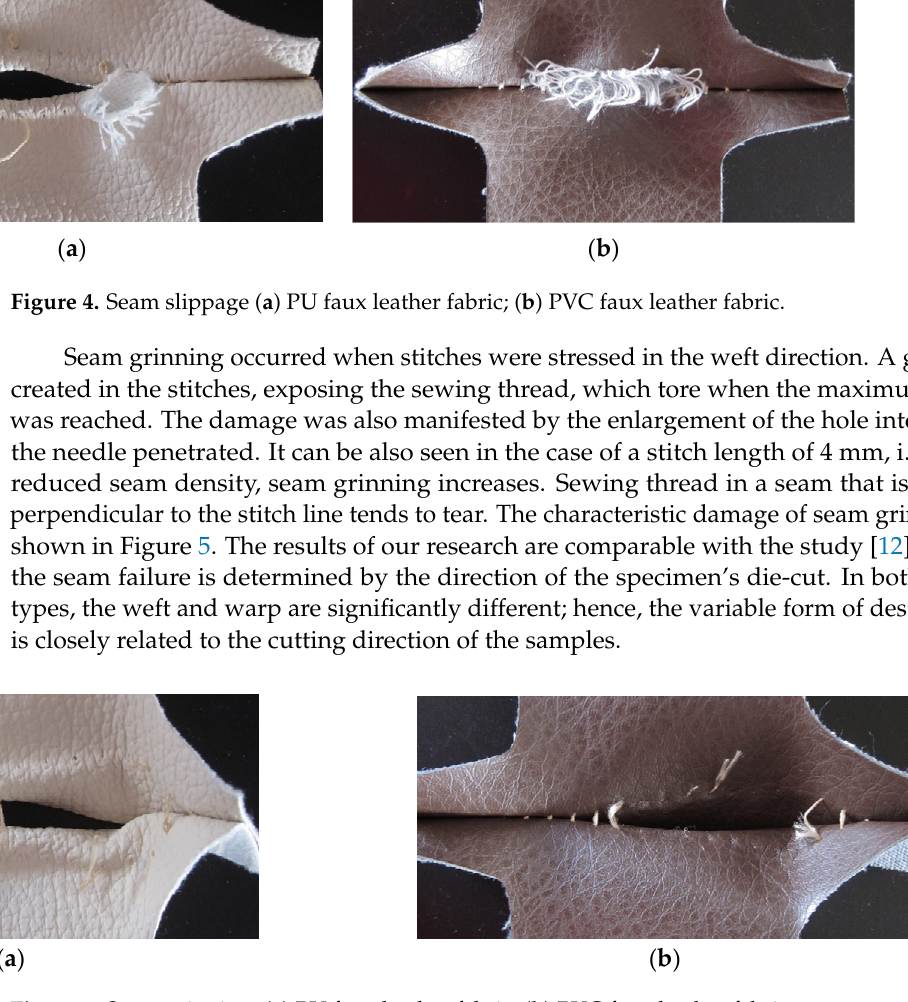
Figure 5. Seam grinning: ( a ) PU faux leather fabric; ( b ) PVC faux leather fabric.